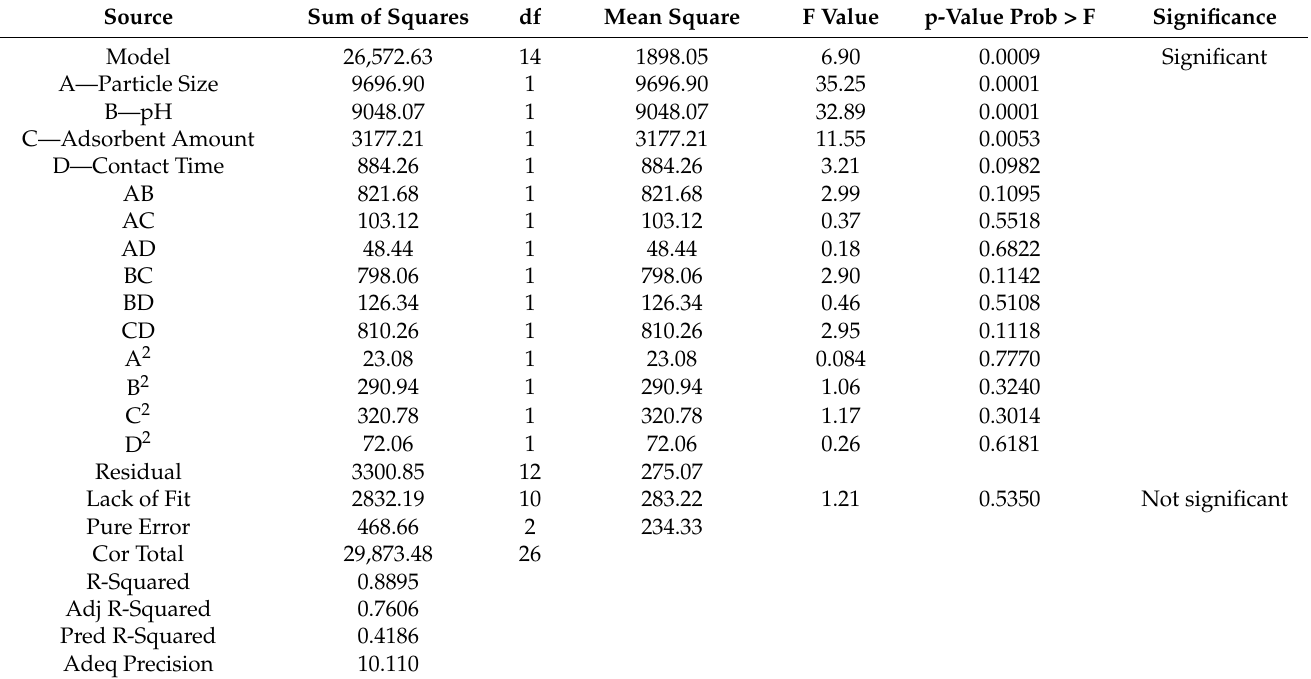
Table 3. ANOVA analysis of the quadratic model for predicting rare earth